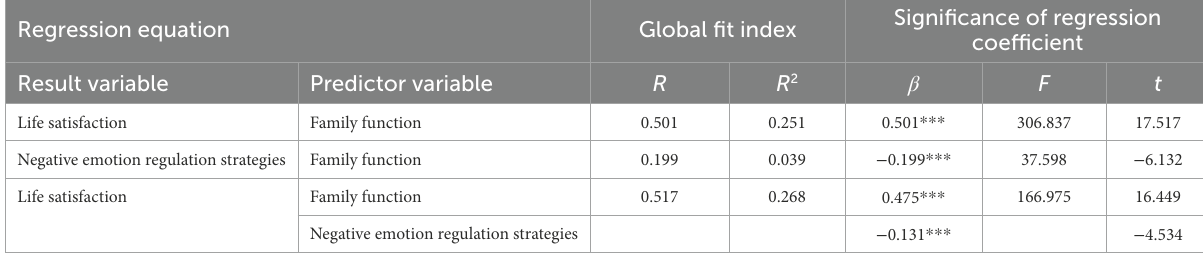
TABLE 5 Regression analysis of the relationship between family function, negative emotion regulation strategies, and life satisfaction.